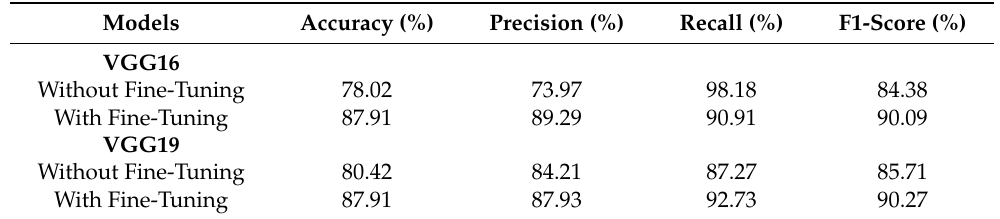
Table 11. Models with transfer learning from Dataset A (labeled brain tumors) for disc state classification.